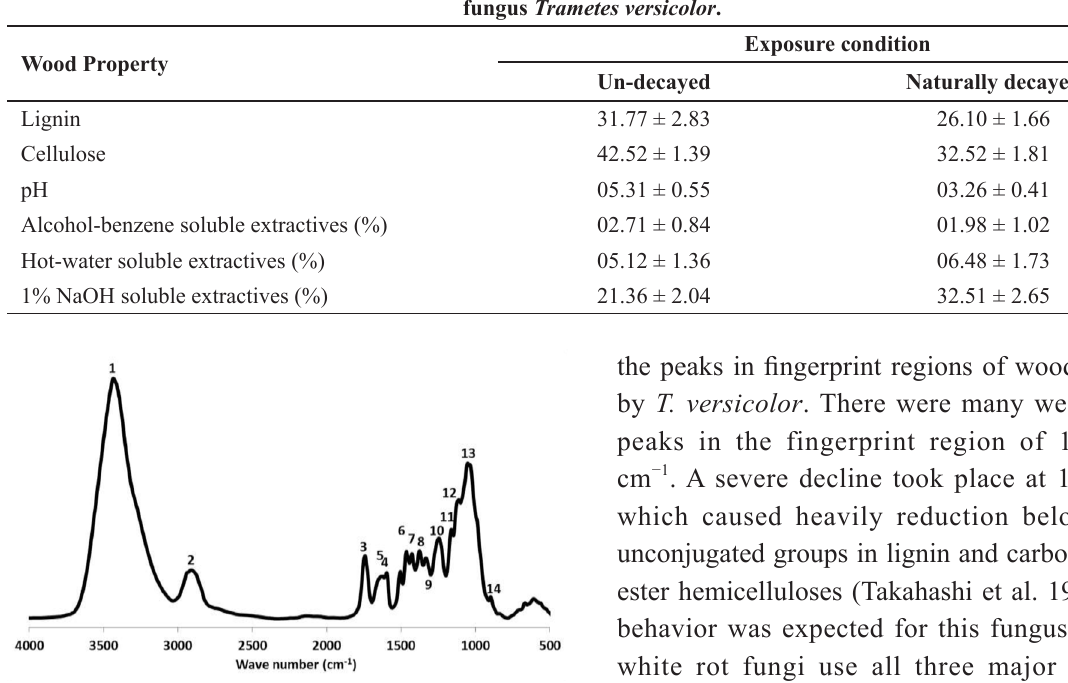
Figure 1 - FT-IR spectrum bands of un-decayed Carpinus